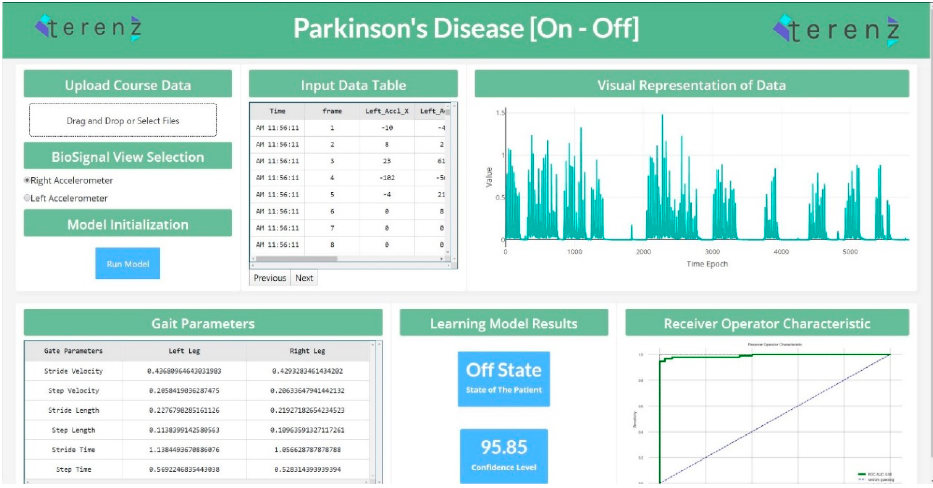
Figure 4. State Detection Web Application (https://parkinson-on-off.herokuapp.com/).